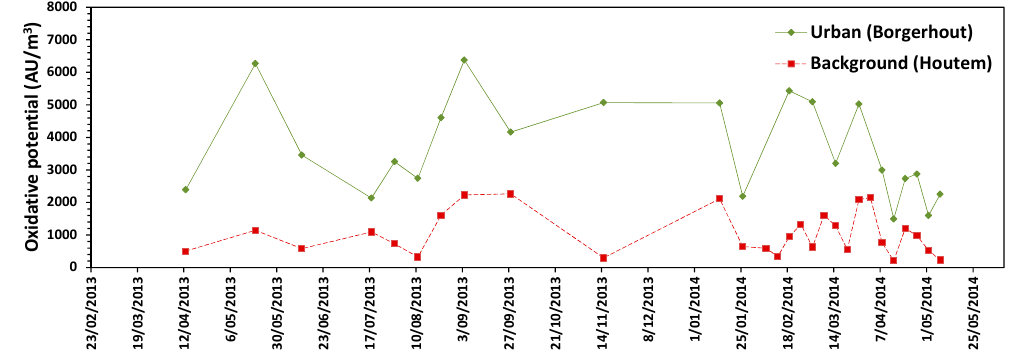
Figure 4. Time series of oxidative potential of individual PM 10 air samples between April 2013 and May 2014 for each sampling site. OP was measured directly on the filters. Values represent one measurement per filter.